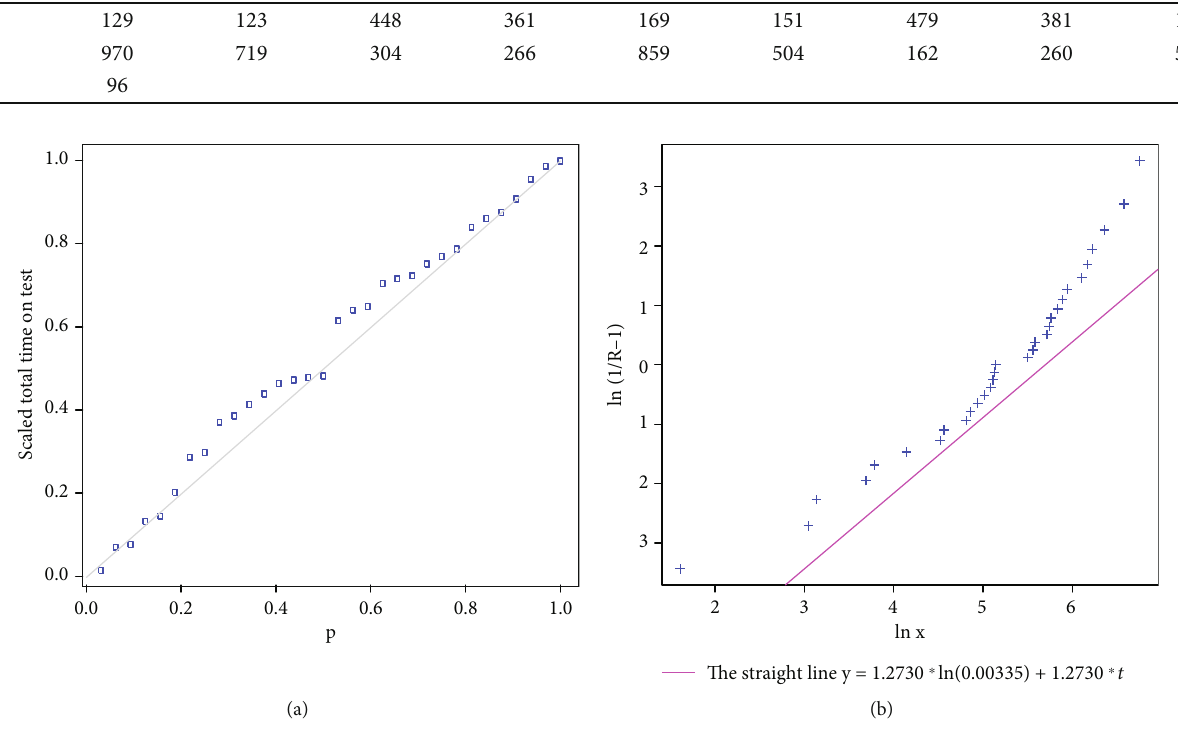
Figure 6: The TTT plot (a) and LLP (b) for data set of Table 6. Table 7: Results of fi tting MLL and some alternative models to data set of Table 6.